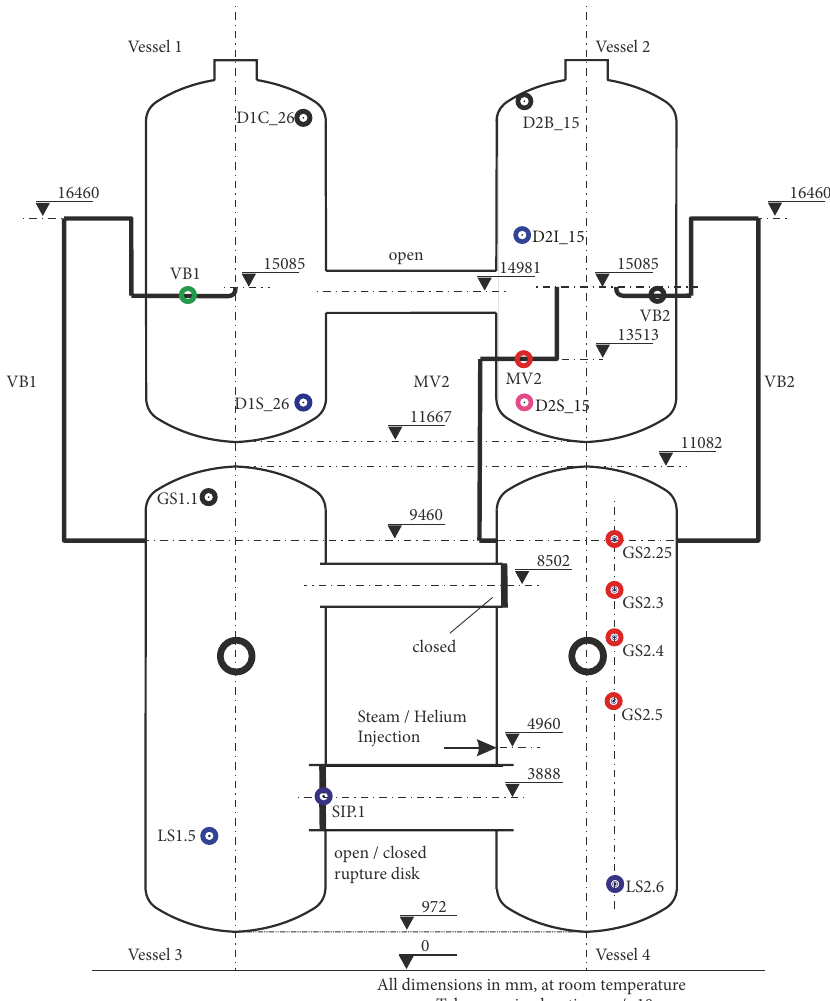
Figure 3: Four PANDA vessels with the main elevations of the pipes connecting the vessels and with selected concentration and temperature measurement positions depicted as